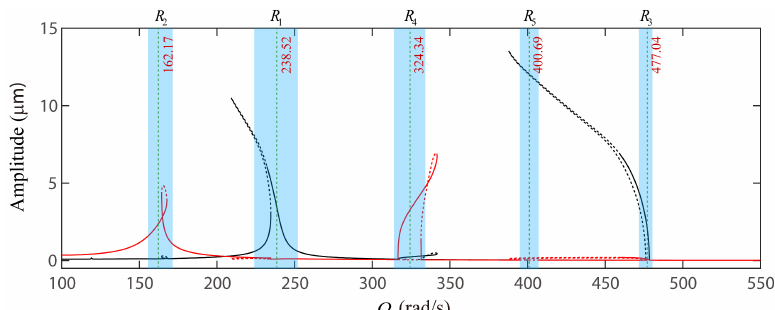
Figure 2. For δ 0 = 1.5 μ m, stable (solid) and unstable (dashed) varying compliance (VC) periodic peak-to-peak frequency–response curves in x (red line) and y (black line) directions.